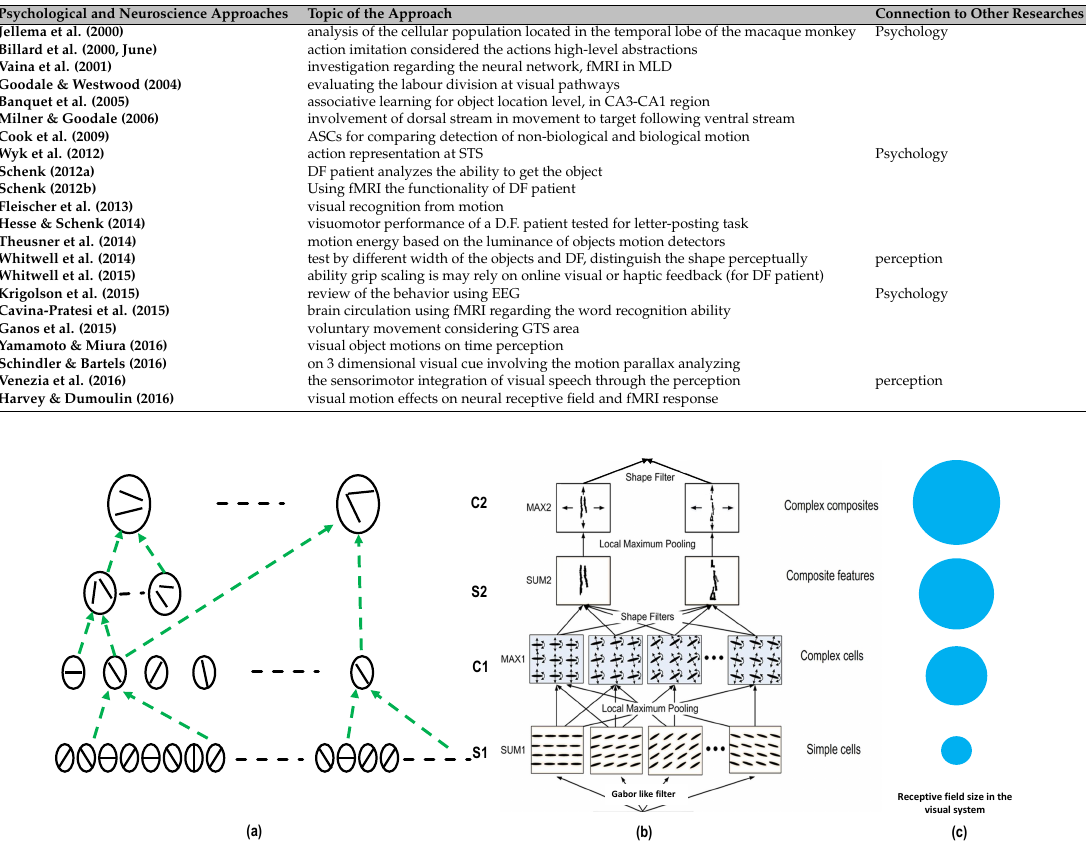
Figure 6. ( a ) The scheme representation of a stream of visual processing located in human cerebral cortex and the ventral stream information of early visual areas (V1þ) and its projection in the occipito-temporal cortex and dorsal stream (blue) projection of the information to the posterior parietal cortex are shown. The indicated routes represented by the arrows and involvement of complex interconnections [155]; ( b ) also follows the scheme representation of human (or any objects) in ventral stream from simple cells to complex composites; ( c ) a presentation of receptive field from early vision till recognition in both